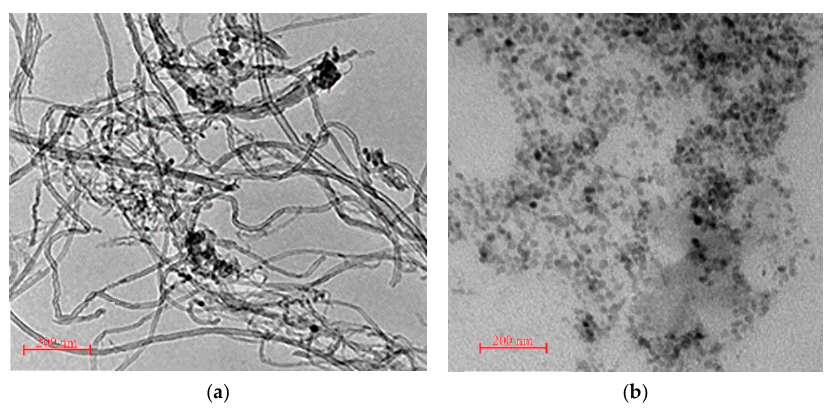
Figure 1. Morphology analysis with HRTEM: ( a ) CNT; and ( b ) nanoparticles SiO 2 (NS).